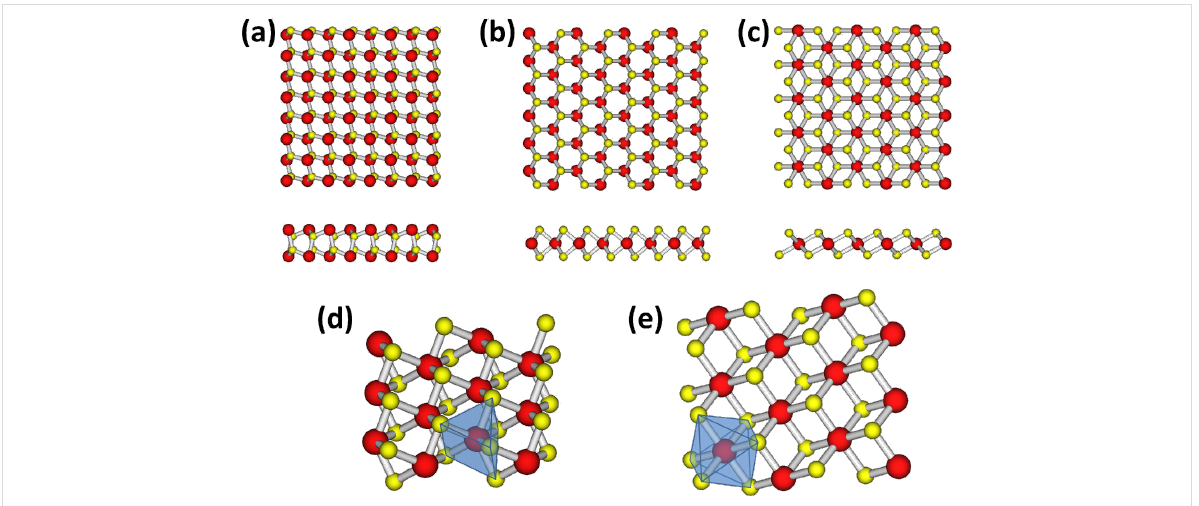
Figure 2: Structures of a monolayer of (a) MX and (b–e) TMX 2 . The TMX 2 layer occurs in two configurations with the metal atoms coordinated either (b)/(d), trigonal prismatically, or (c)/(e), octahedrally. The metal and chalcogenide atoms are shown as red and yellow spheres, respectively.